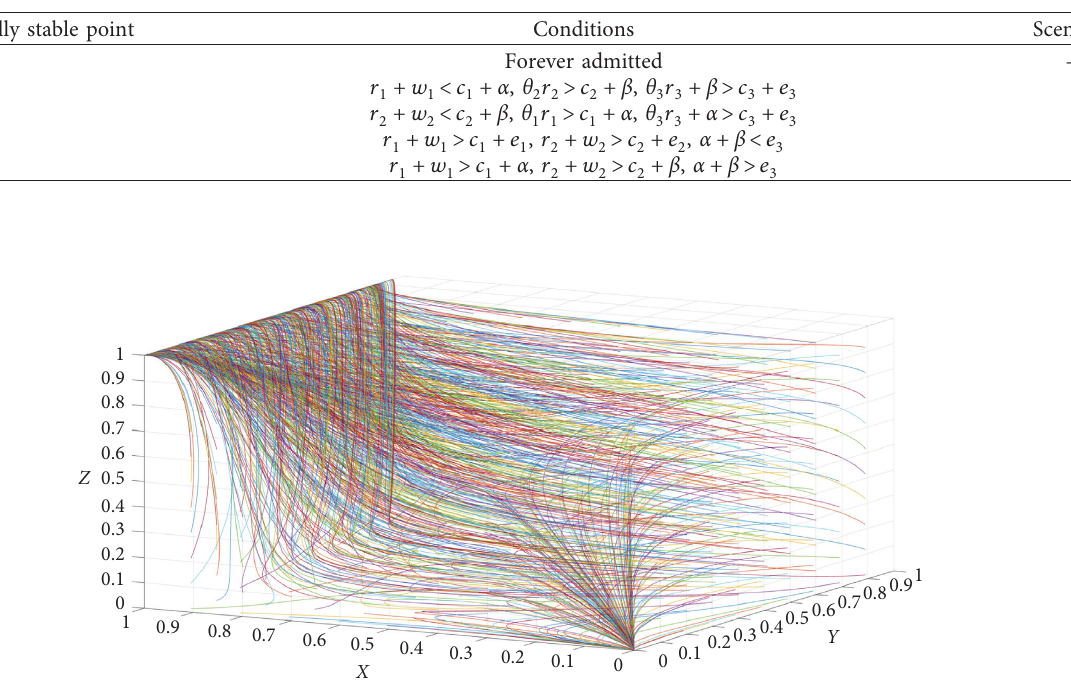
Figure 2: Evolution paths of scenario